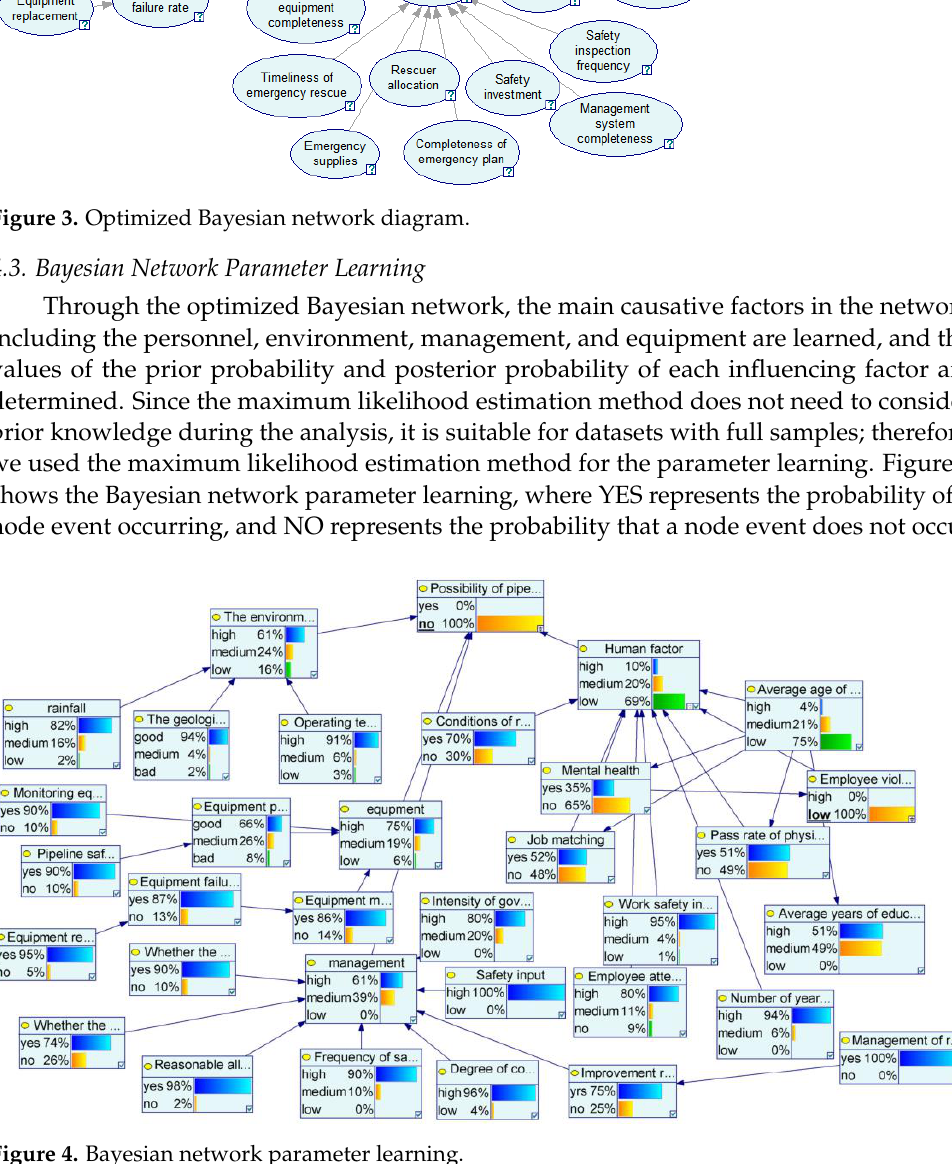
Figure 4. Bayesian network parameter learning.